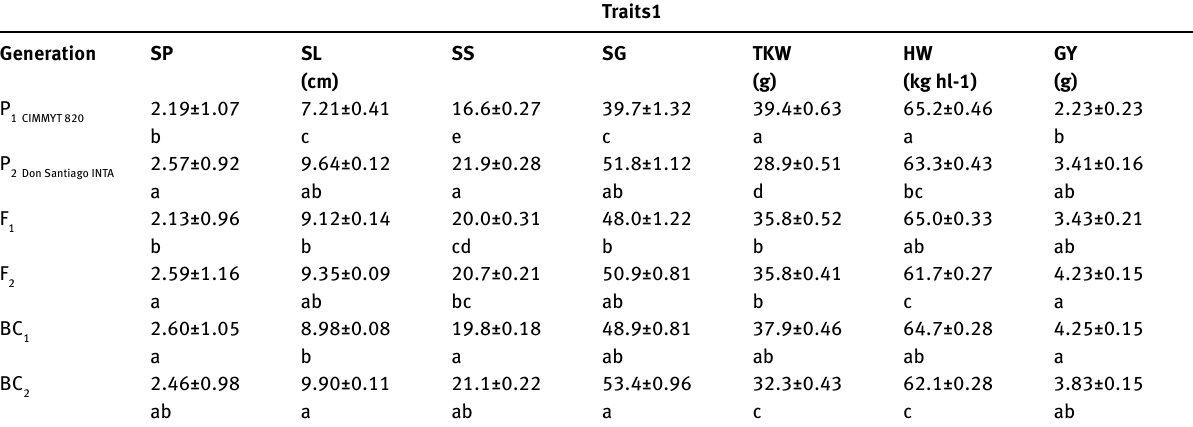
1 Traits: SP = spikes per plant, SL = spike length, SS = spikelets per spike, SG = number of grain per spike, TKW = thousand kernel weight, HW = hectoliter weight, GY = grain